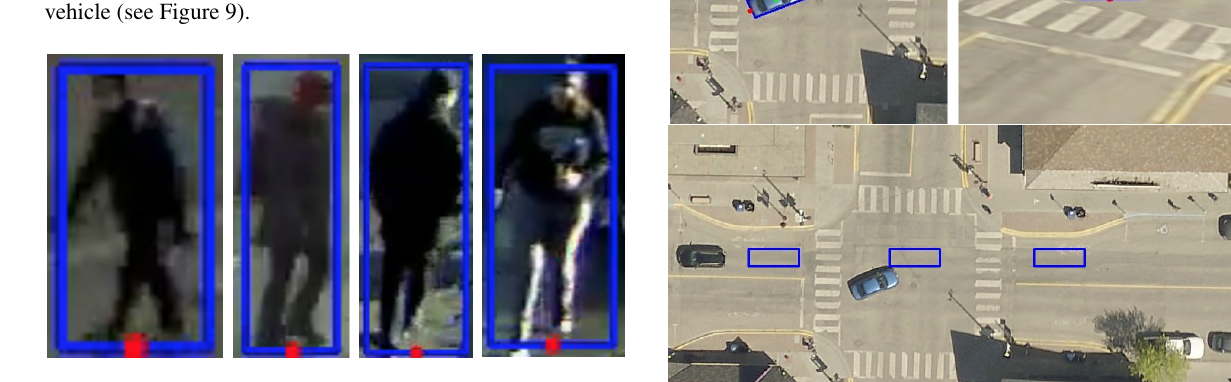
Figure 10. Error